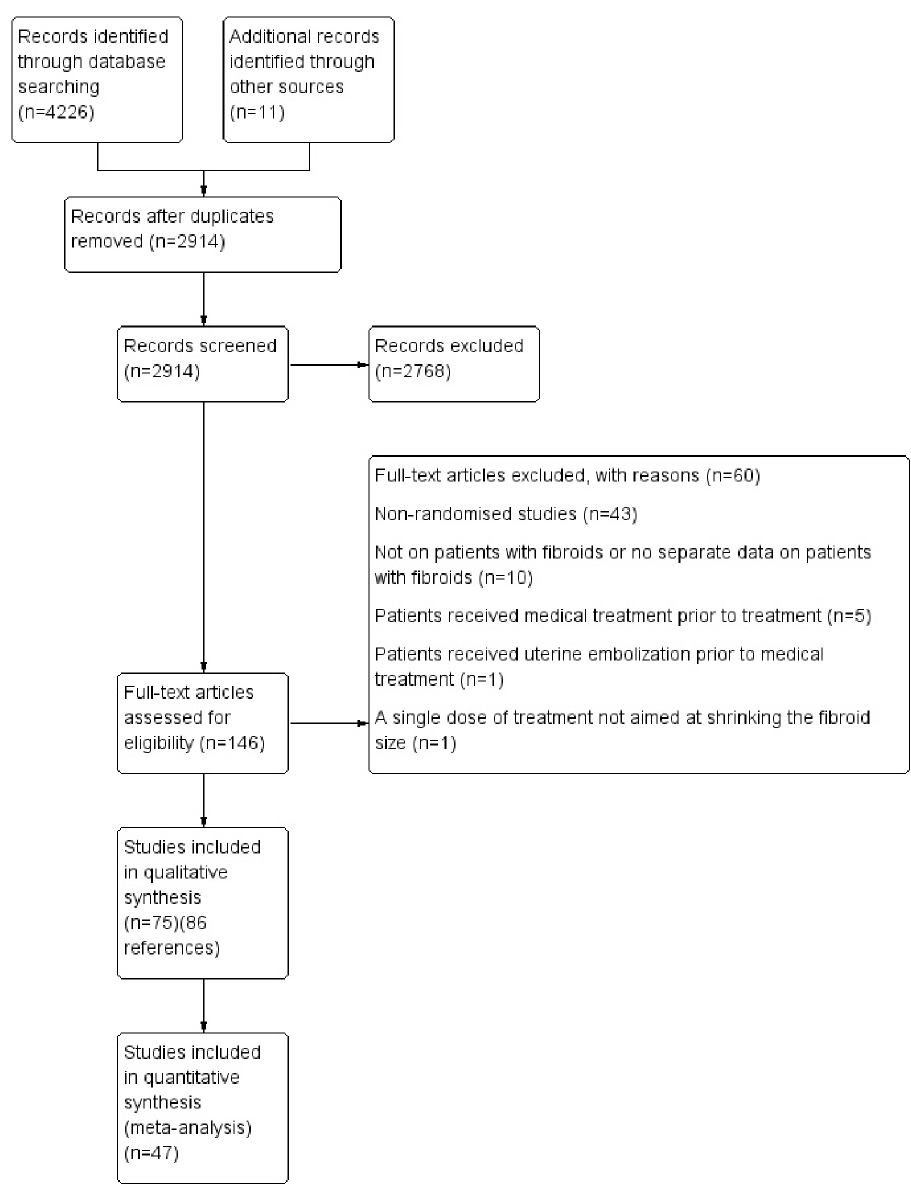
Fig 1. Reference flow